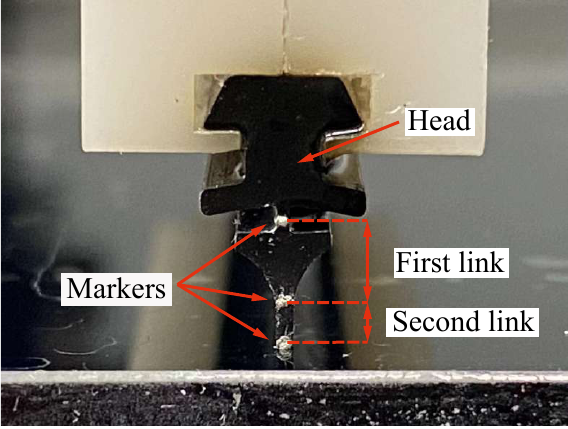
Figure 9. Experimental apparatus ( a ) without attack angle and ( b ) with an 18-degree attack angle. An enlarged view of the wiper blade is shown in Figure 10. There are three white dots marked on the neck, the center of rotation of the second link, and the tip of the wiper blade.